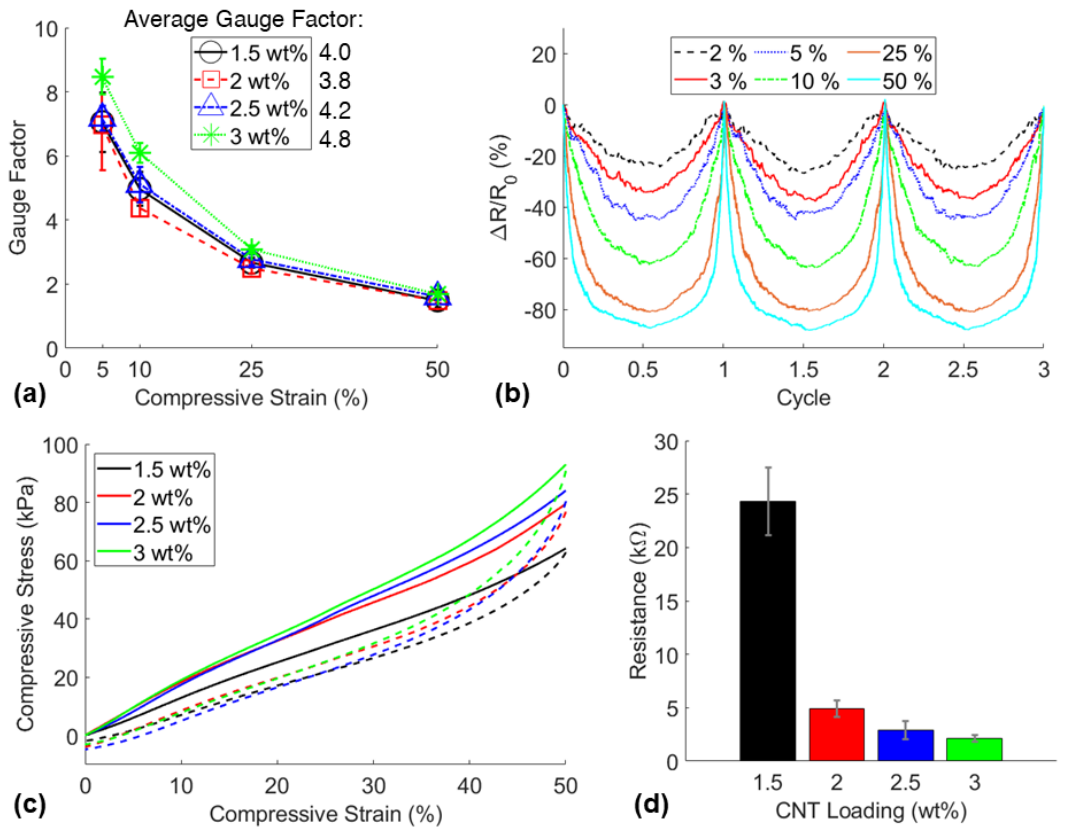
Figure 6. ( a ) Sensitivity comparison of CNT1.5P70, CNT2P70, CNT2.5P70, and CNT3P70 sponges, ( b ) representative relative resistance change signals of a CNT3P70 sponge under maximum compressive strains of 2%, 3%, 5%, 10%, 25%, 50%, respectively, ( c ) stress–strain curves of sensors in compression, and ( d ) the average resistances of the sensors.